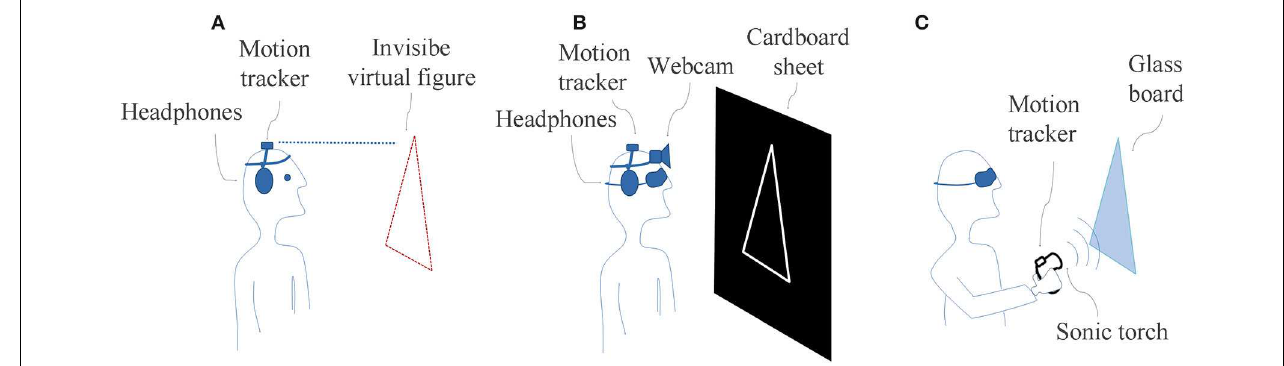
FIGURE 1 | Illustration of shape recognition task with different auditory-substitution-of-vision devices. (A) subject equipped with the minimalist SSD (Invisible shapes discoverer.); (B) subject equipped with the traditional SSD (vOICe); (C) subject assisted